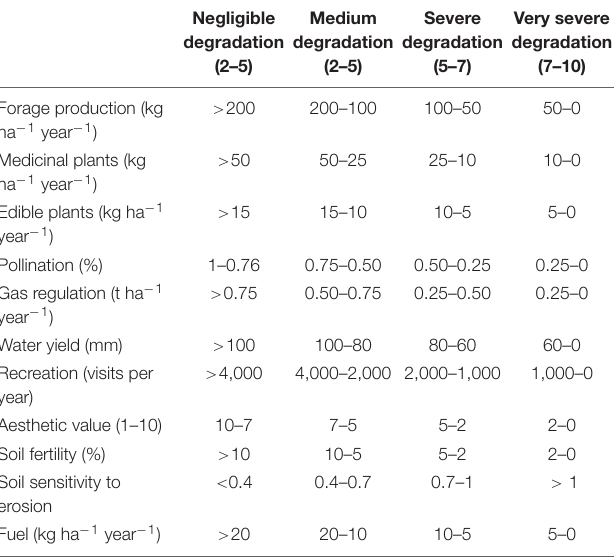
TABLE 1 | Potential of the four degradation classes in providing different ecosystem